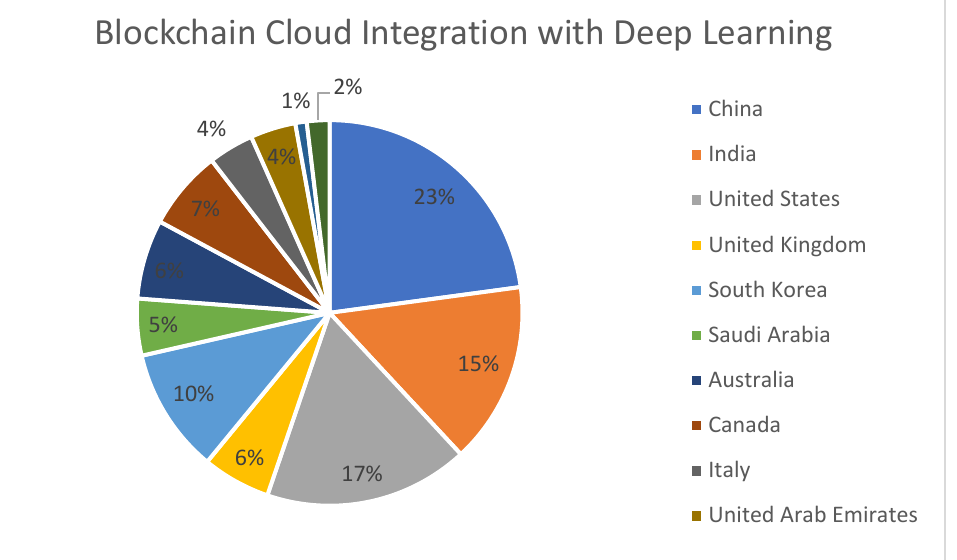
Figure 20. Region-specific publication distribution for Blockchain–Cloud integration with Deep Learning.